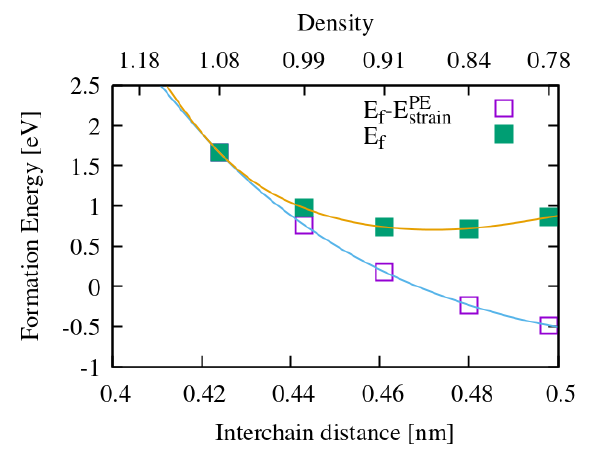
Figure 4. Solution energy of an oxygen molecule in crystalline PE as a function of the interchain distance. For both the yellow and the blue curves the oxygen molecule is inserted in a model of PE with scaled in plane lattice parameters, so to modify the interchain distance and not the dimensions along the chain. The equilibrium interchain distance is 0.424 nm; the yellow curve gives the standard solution energy (E f ), computed with respect to the equilibrium structure; the blue curve takes as a reference a PE crystal with the same scaled lattice parameters as that of the supercell hosting the molecule, that is we remove the strain energy required to dilate the PE at 0 K (E PE chemical potential, in both cases, is the energy of an isolated O 2